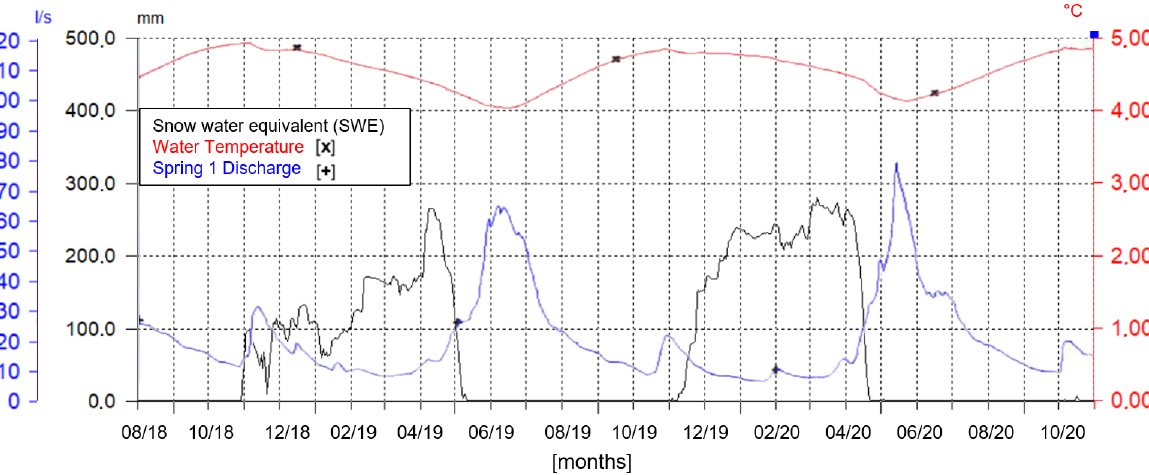
Figure 8. Daily means time series of SWE, water temperature and Spring 1 discharge rate from summer 2018 to autumn 2020 (Hydras 3 software layout).